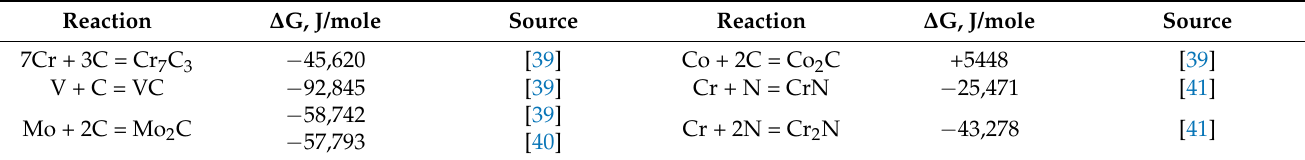
Figure 3. XRD of the surface after thermal diffusion chromium plating of the sample: ( a ) without additives; ( b ) with 5% FeV; ( c ) with 5% Mo; ( d ) with 5% Co. Table 3. Data on the change in the Gibbs free energy of the formation of carbides and nitrides at 1000 ◦